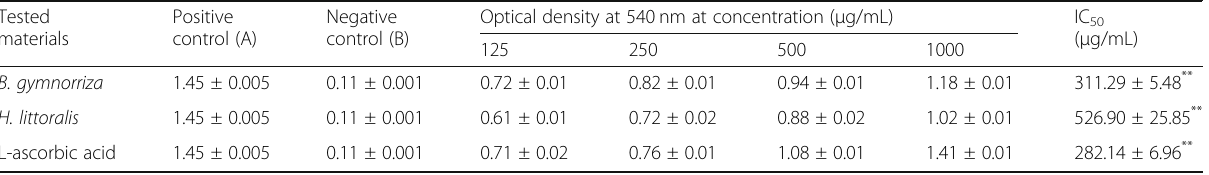
Table 2 Anti-hemolytic activity of methanol leaf extracts of selected mangrove plant species Tested